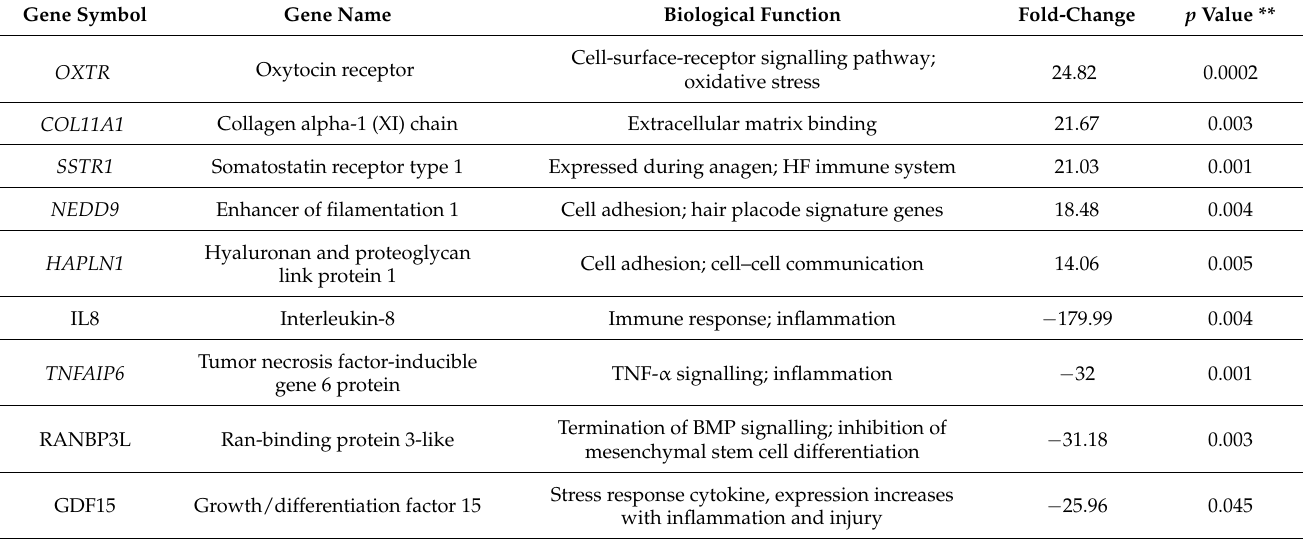
Table 1. DEGs in the 3D spheroid system compared with the 2D culture